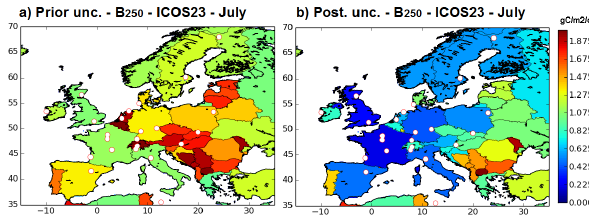
Figure 12. Standard deviations (gCm − 2 day − 1 ) of the prior (a) and posterior (b) flux uncertainties at country scale. Posterior un- certainties are given for inversions using ICOS23 (white circles) and the reference inversion setup. Red/blue colors indicate rel- atively high/low uncertainties (with min = 0gCm − 2 day − 1 and max = 1.975gCm − 2 day − 1 in the color